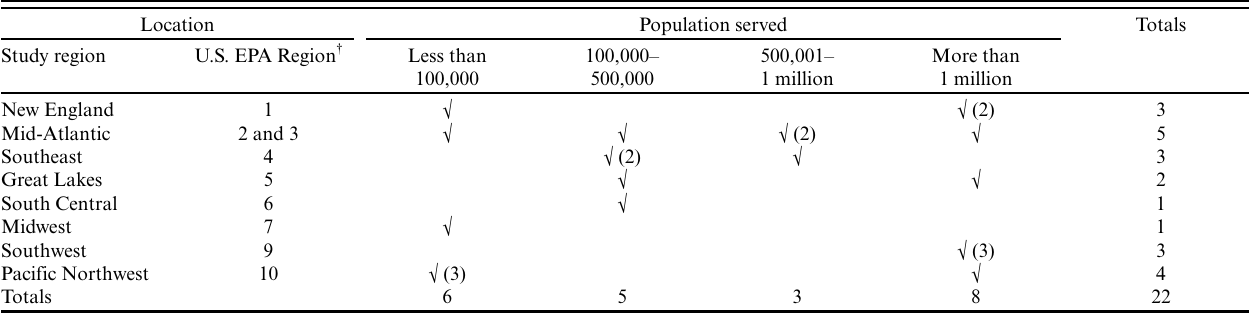
Table 1 . Composition of study sample